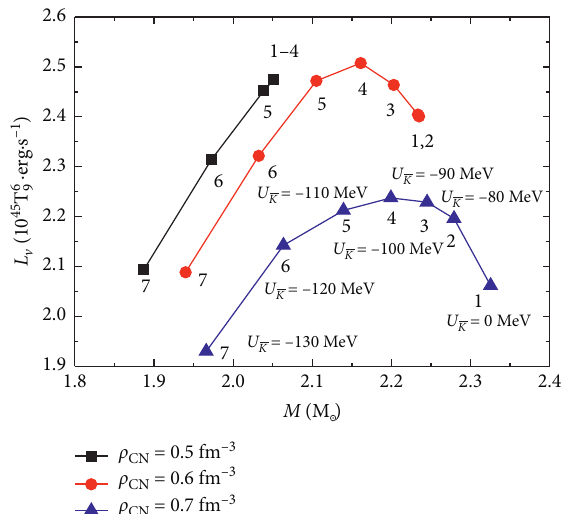
� − 80 to K Figure 3: Neutrino luminosities of the nucleonic direct Urca processes as a function of NS mass